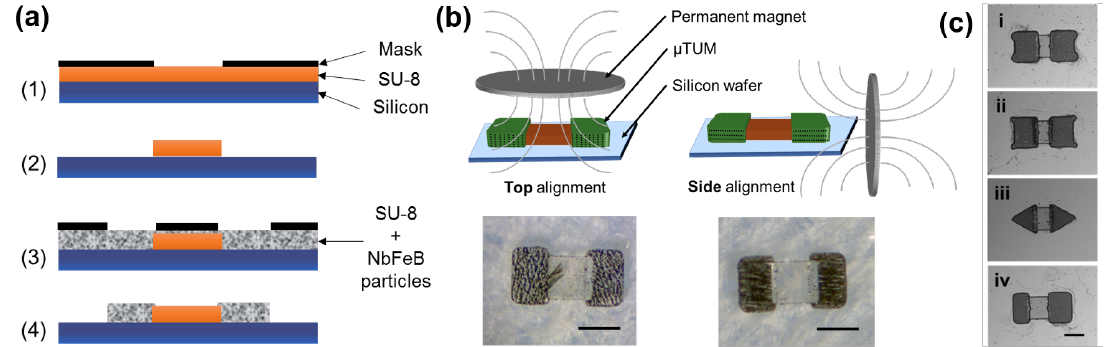
Figure 5. Fabrication process of microscale magnetic tumbling motors ( µ TUM). ( a ) Photolithography process followed for the the fabrication of µ TUM. ( b ) Magnetic particle alignment techniques. Magnets located above the robot result in alignment along the geometric z-axis and sideways tumbling (ST); magnets located beside the robot result in alignment along the geometric x-axis and lengthwise tumbling (LT). ( c ) Optical images of the different geometric variations on the µ TUM ending sections that have been explored: (i) rounded corners, (ii) sharp corners, (iii) triangles and (iv) (asymmetric) rounded rectangles. Scale bar, 300 µ